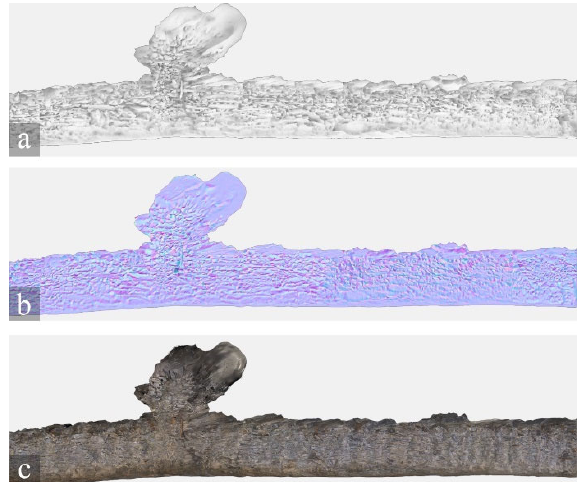
Figure 10. Occlusion (a), normal (b) and diffuse (c) maps baked for the tunnel 13